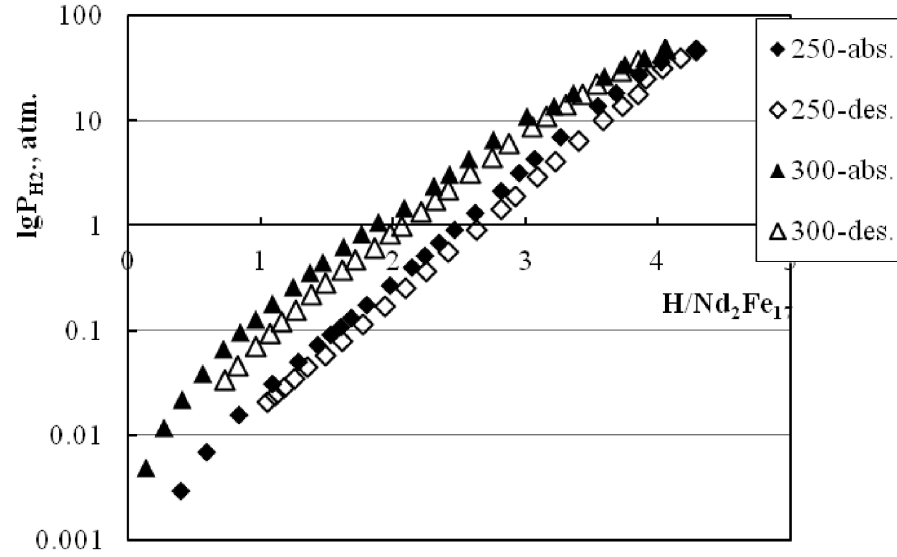
Figure 1. Absorption and desorption isotherms for Nd 2 Fe 17 -H 2 at 250 and 300 ◦ C.